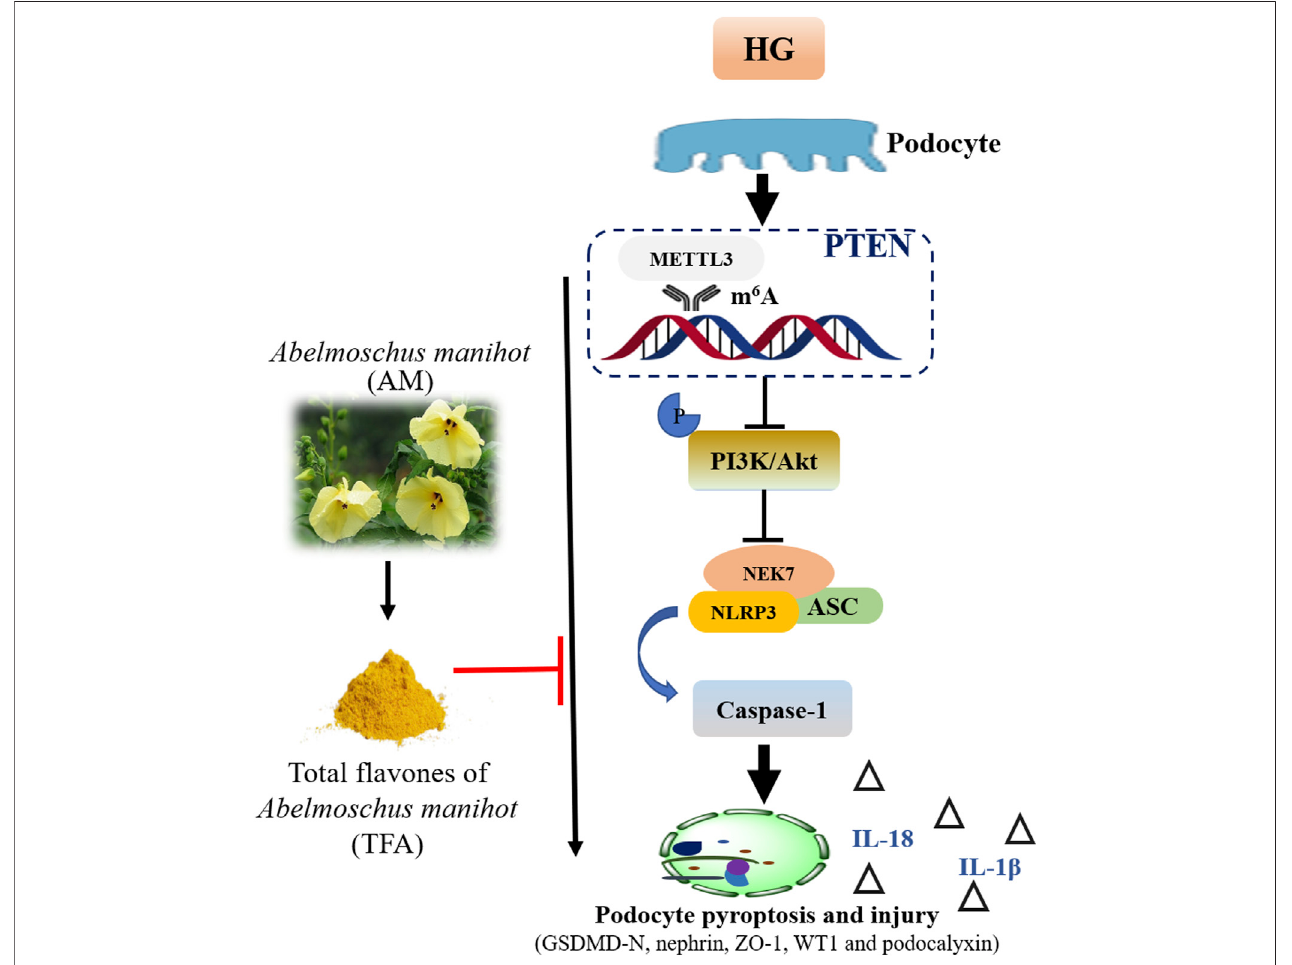
FIGURE12| SchematicdiagramshowinghowTFAamelioratespyroptosisandinjuryinpodocytesexposedtoHGconditions.Abbreviations:TFA,total fl avonesof Abelmoschus manihot ; HG, high glucose.